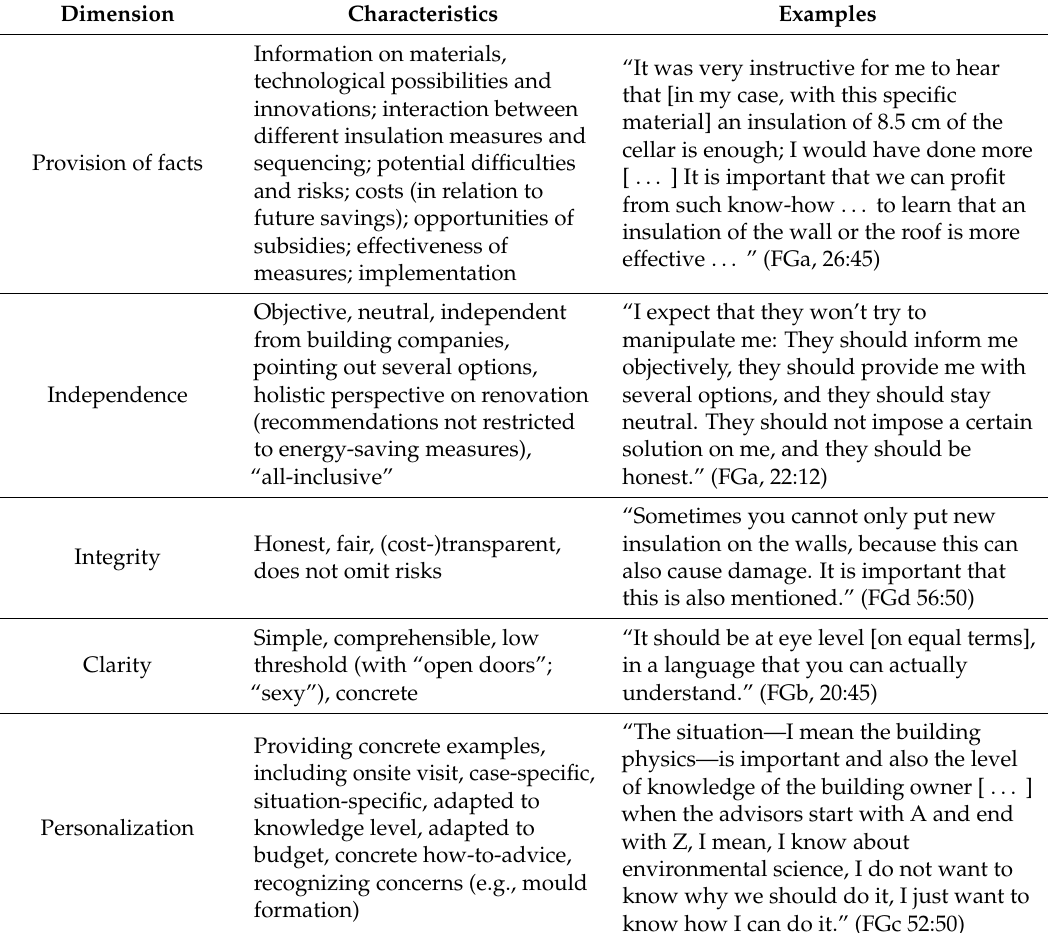
Table 4. Dimensions of ideal advice services as described by recipients of